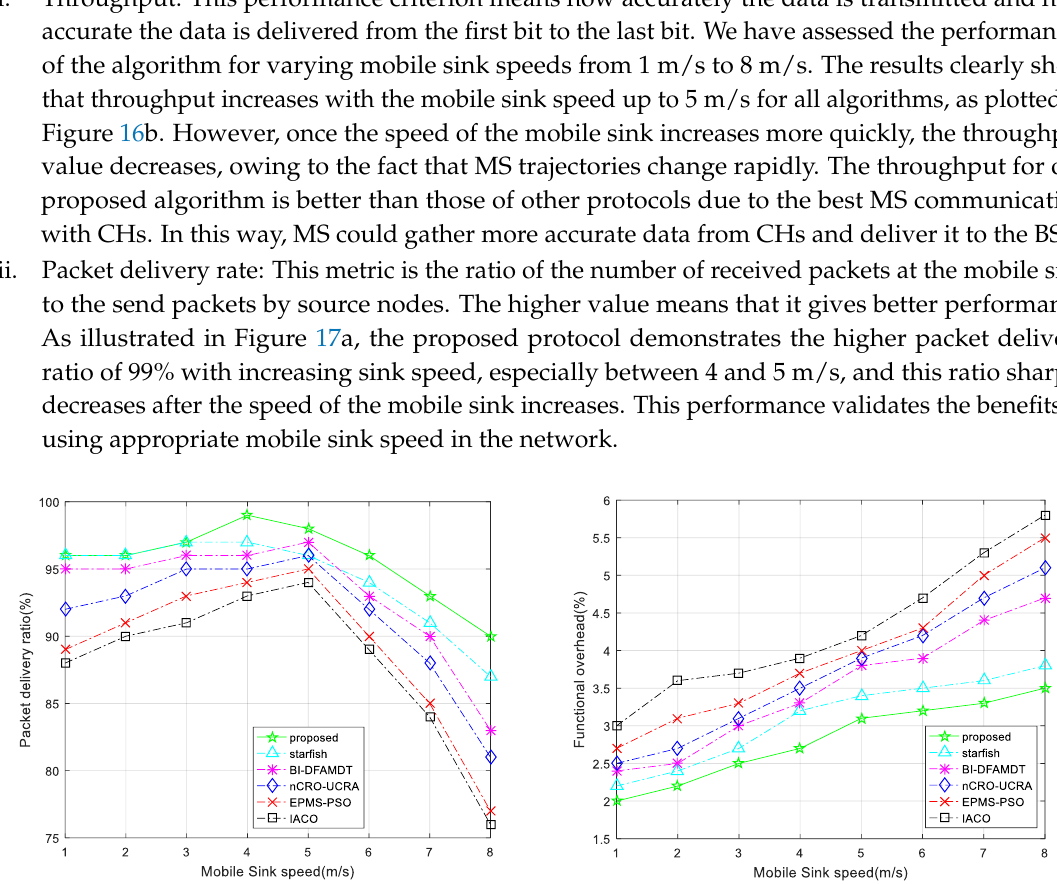
Figure 16. Comparison of the proposed scheme with existing algorithms versus packet delivery delay and throughput: ( a ) Packet delivery delay; and, ( b ) Throughput.